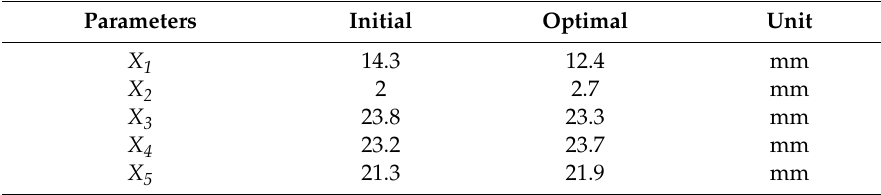
Table 3. Comparison of design variables.